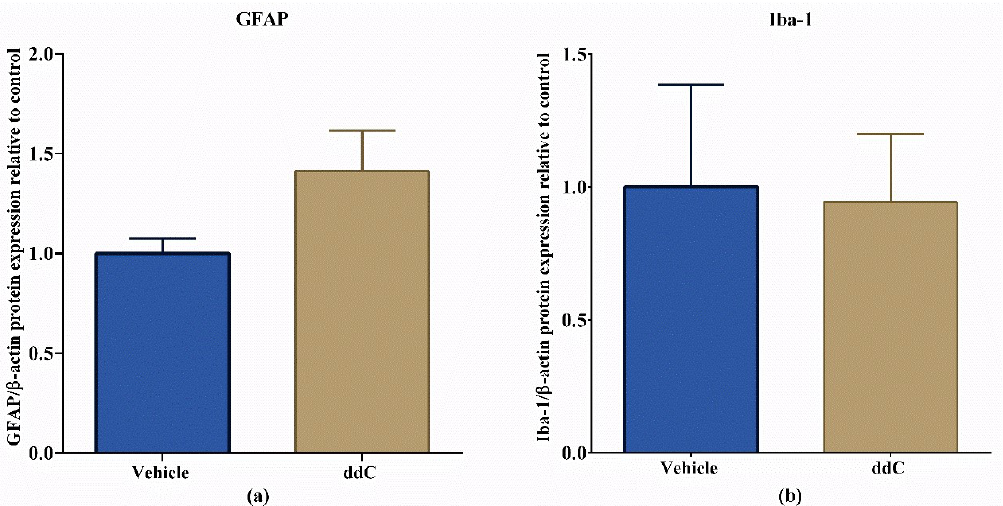
Figure 5. Effect of treatment with 2′-3′-dideoxycytidine (ddC) on protein expression of ionized calcium binding adaptor molecule 1 (Iba-1) and glial fibrillary acidic protein (GFAP) in the brains of female BALB/c mice at day 7 post-first-injection (dpi) of ddC. Relative expression of ( a ) GFAP and ( b ) Iba-1 in the brain. The protein expression was measured using the Wes TM capillary-based protein electrophoresis. The ratio between the area of the electropherogram of the protein of interest and the area of β-actin were calculated and normalized to the control group. The bars represent the mean ± SEM of values obtained from eight animals for GFAP and median and interquartile range of values obtained from four animals for Iba-1.